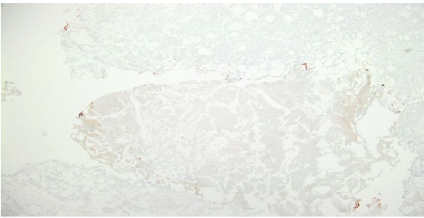
Figure 5: Malignant cells showing minor and heterogenic positivity for cytokeratin 7 marker on immunohistochemistry.